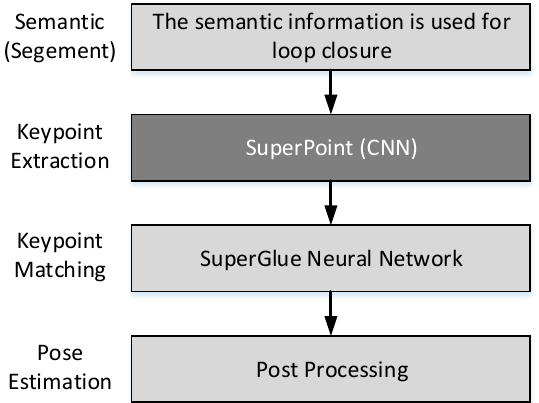
Figure 1. SuperPoint-based feature point